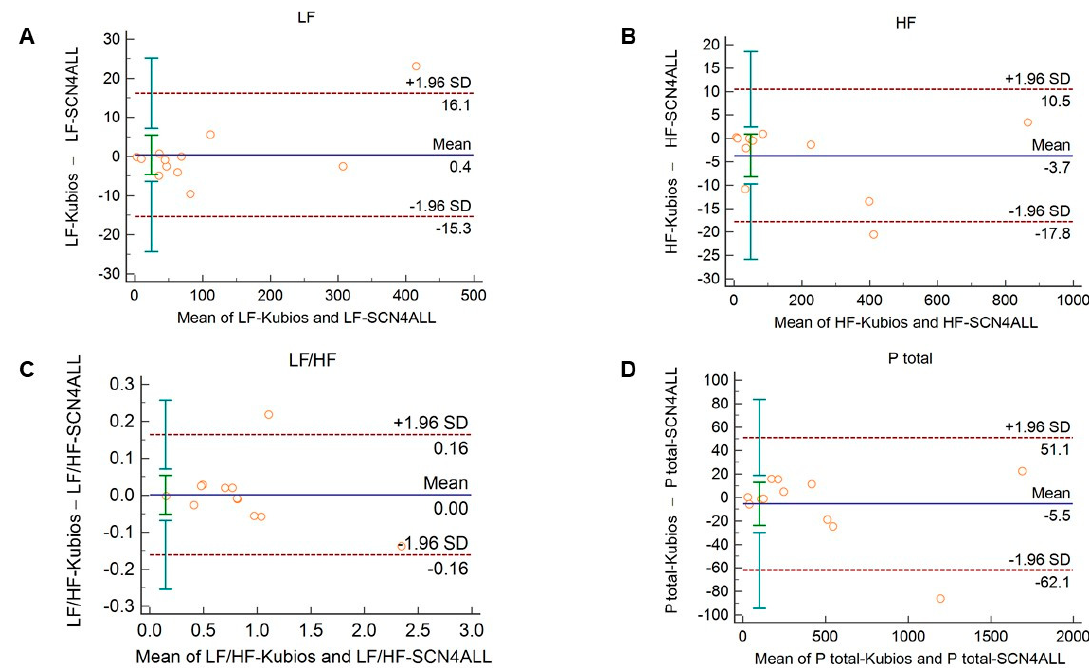
Figure 6. Bland–Altman plots of frequency-domain HRV/PRV parameters calculated by the SCN4ALL (indicated as ‘parameter name-SCN4ALL’) and the Kubios Premium HRV (indicated as ‘parameter name-Kubios’) algorithms from 2-min long PPG recordings obtained from diabetic patients under resting conditions. ( A ) Ptotal (total spectral power), ( B ) LF/HF (ratio of low frequency to high frequency), ( C ) LF (absolute power of the low-frequency band (0.04–0.15 Hz)), ( D ) HF (absolute power of the high-frequency band (0.15–0.4 Hz)). Bias is calculated as the mean of differences (indicated as ‘Mean’—blue solid line) and is presented with 95% confidence intervals (green) and +/ − 1.96 standard deviations (SD) and their confidence